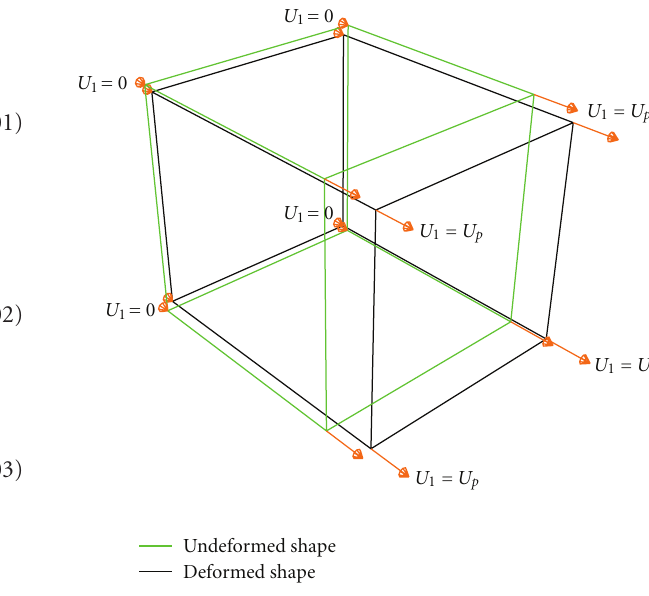
Figure 6: Boundary conditions for tensile loading.